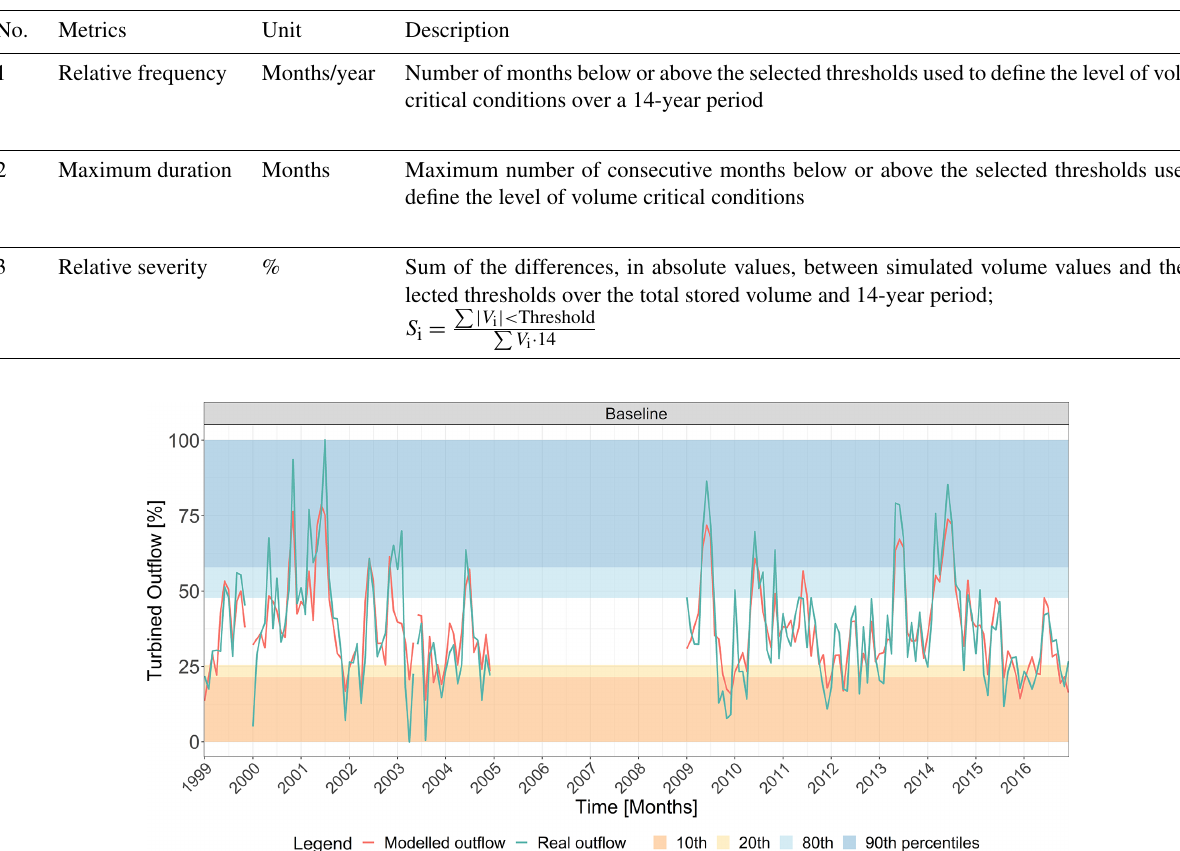
Table 3. Metrics implemented to characterize extreme events of low and high volume stored in the S. Giustina reservoir for RCP4.5 and RCP8.5 future projections, adapted from Vogt et al. (2018).